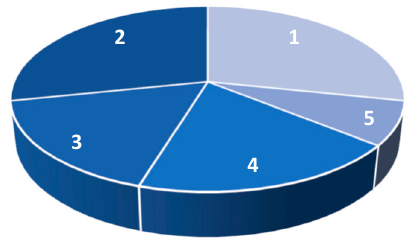
Figure 9. Graph of cluster sizes. Table 1. Distance between